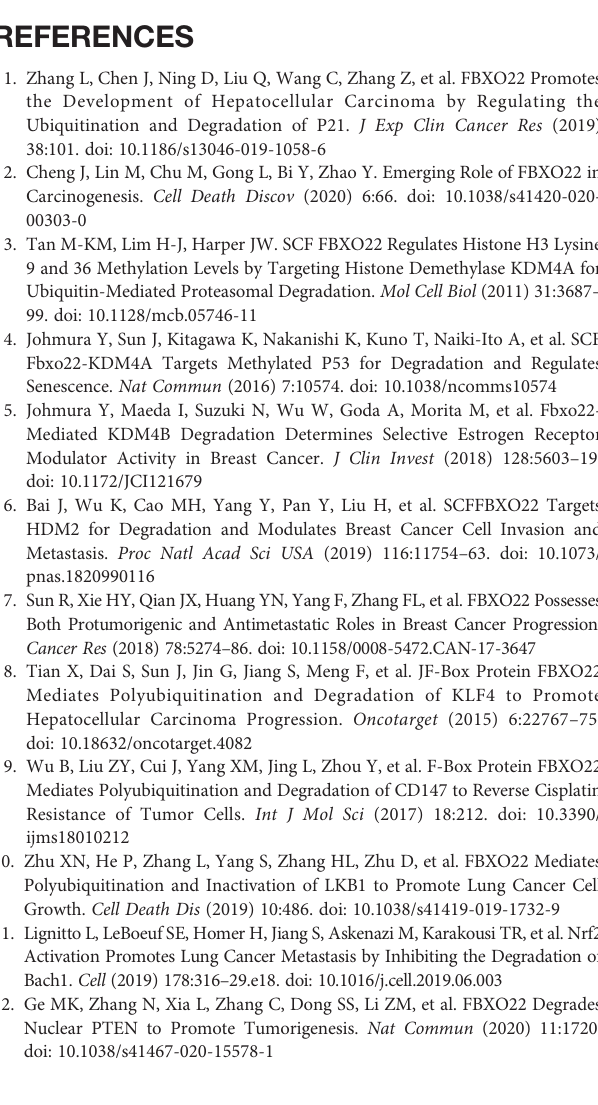
Supplementary Figure 2 | Graph showing tumor versus normal meta-analysis of data with the FBXO22 gene and tumor type using LUNG CANCER EXPLORER. Supplementary Figure 3 | Graph showing survival meta-analysis of data with the FBXO22 gene and tumor type using LUNG CANCER EXPLORER. Supplementary Figure 4 | Features of FBXO22 genetic alterations in different human cancer types from the TCGA, as displayed using the cBioPortal tool. (A) The frequency of different FBXO22 genetic alterations in different tumor types in TCGA. (B) Statistics associated with FBXO22 mutation sites in different tumor types. (C) Heatmap of differentially expressed substrate genes between the mutated and wild- type FBXO22 in different cancer types. (D) BACH1, CDKN1A and MDM2 expression in samples with wild-type or mutated FBXO22 in GBM; BAG3, TP53 and BACH1 expression in samples with wild-type or mutated FBXO22 in COAD; CDKN1A expression in samples with wild-type or mutated FBXO22 in LUSC and SKCM. Supplementary Figure 5 | Spearman correlation heatmap showing the relationship between survival prognosis and methylated CpG islands in FBXO22 .